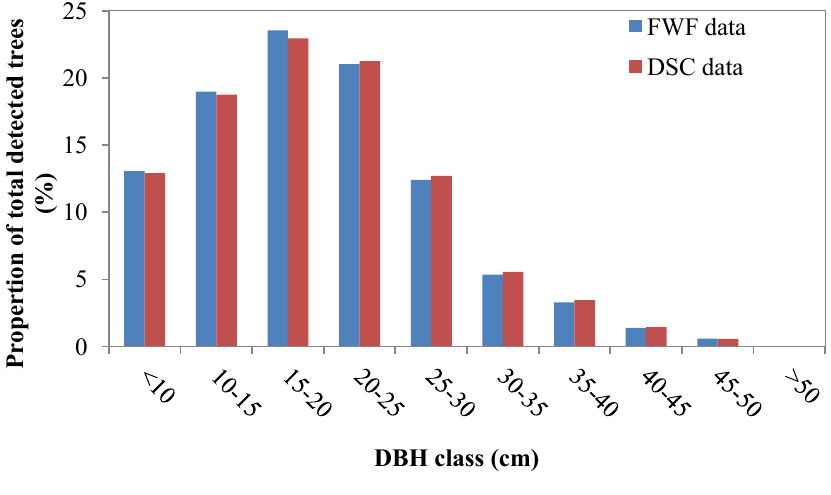
Figure 7. Detection rate by tree